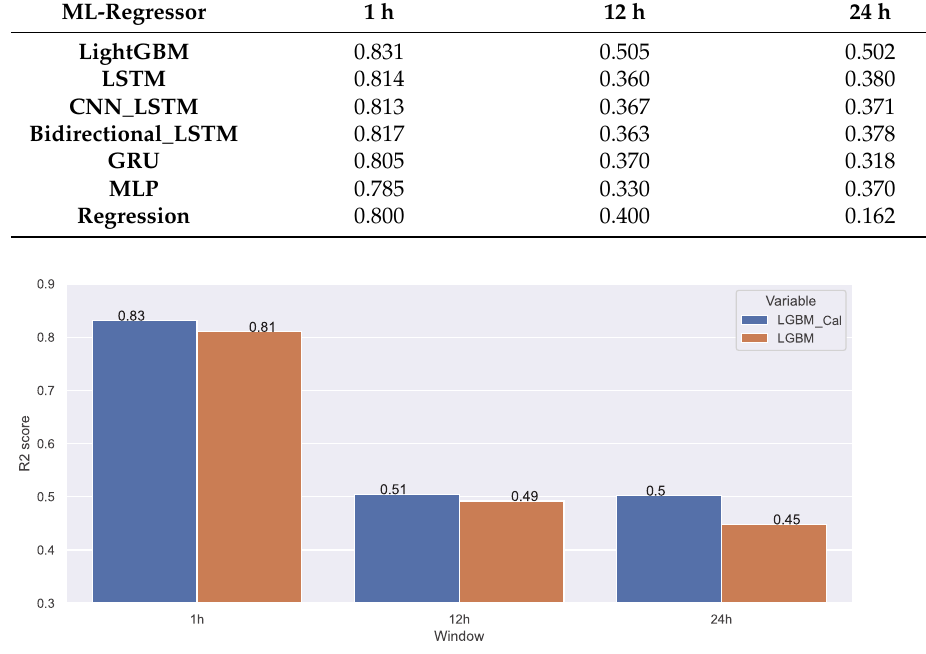
Figure 15. Additional features’ impact on LightGBM